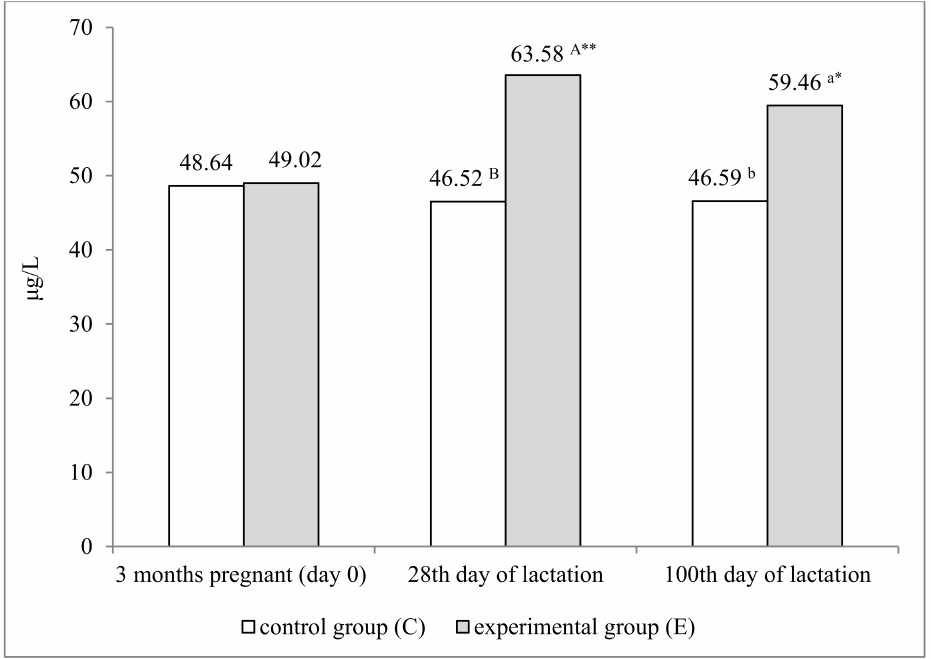
Figure 1. Serum selenium concentration in dams ( µ g/L). a,b — p ≤ 0.05; A,B — p ≤ 0.01; **— p ≤ 0.01; *— p ≤ 0.05—significant difference relative to day 0 (3 months